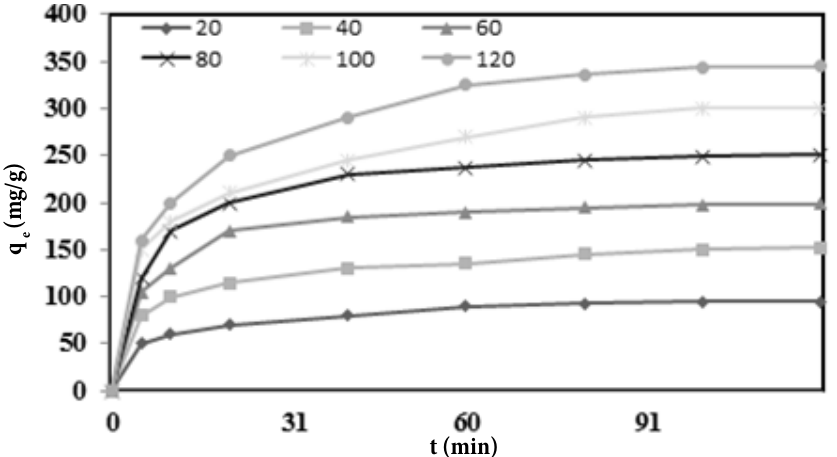
Fig. 6. Effect of initial dye concentration on the adsorption capacity of nanobentonite. Conditions: dose